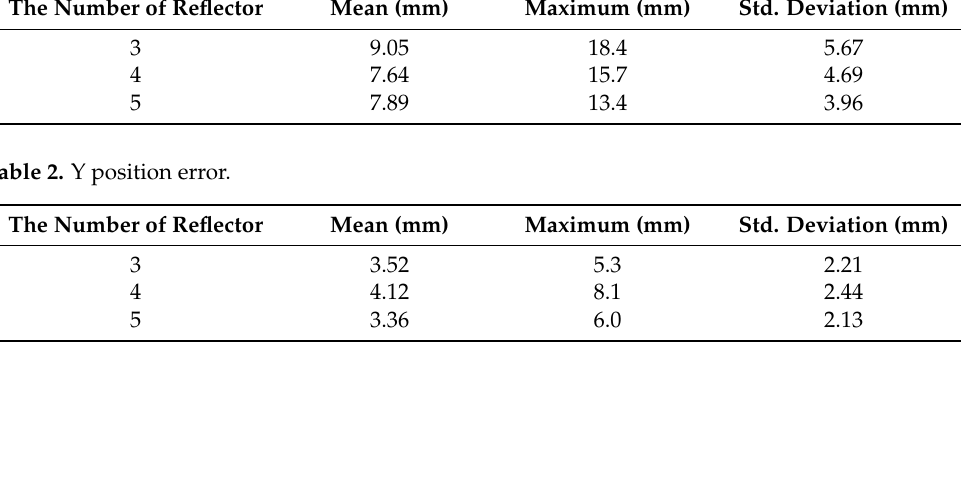
Figure 9. The actual layout environment of reflectors.